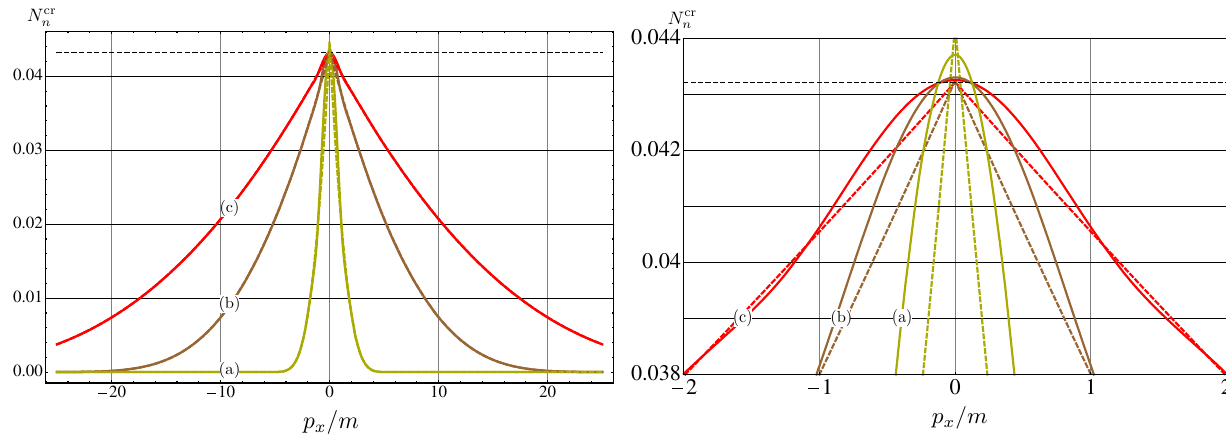
Fig. 2 Differential mean number N cr n of Fermions created by the sym- metric inverse square electric field (1), in which τ 1 = τ 2 . The exact differential mean numbers (16) are represented by red, brown and yel- low solid lines while the asymptotic approximations (23), (25) are rep- resented by dashed color lines. The right panel shows the range of